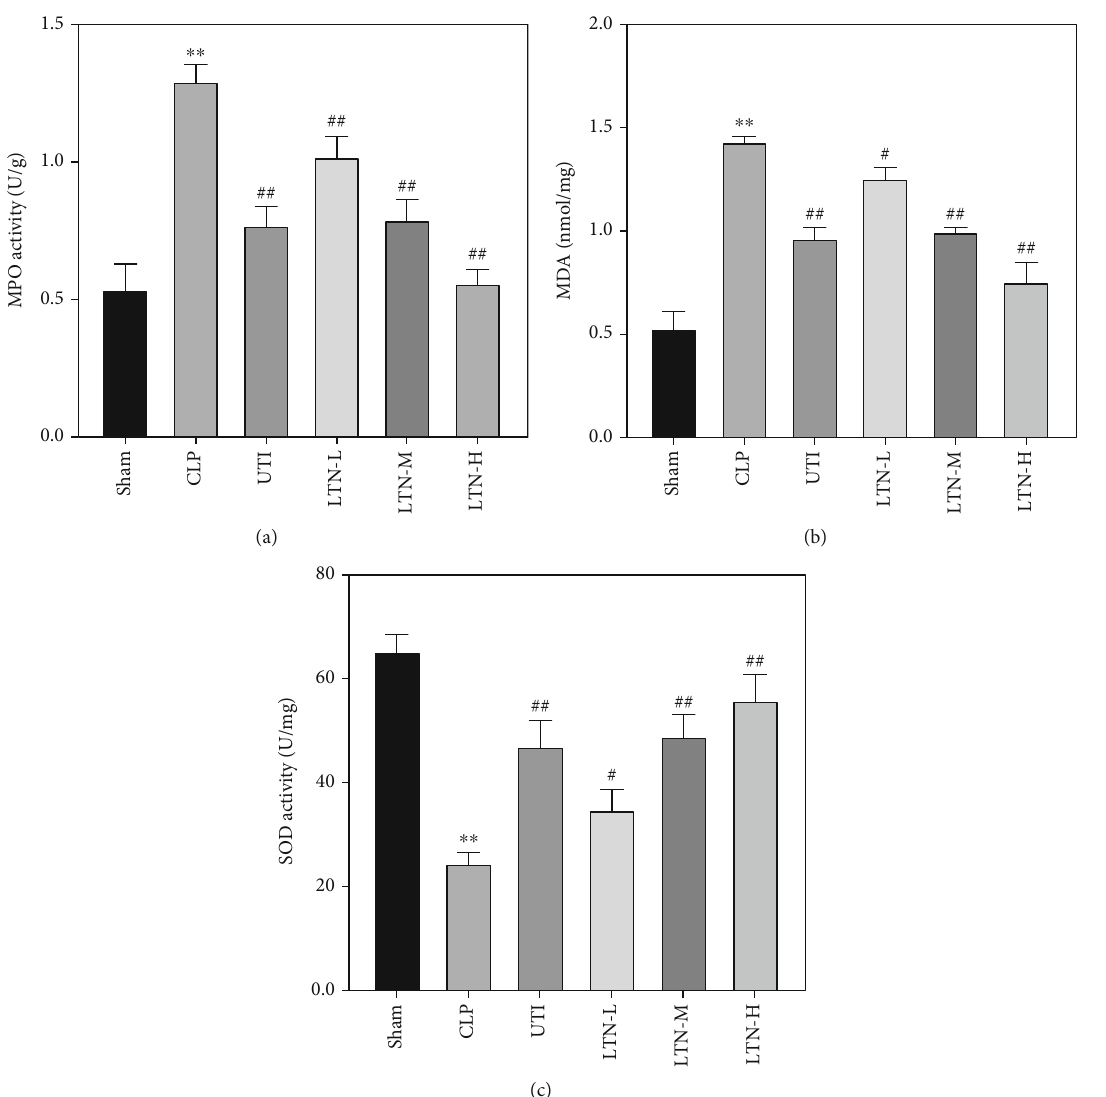
Figure 4: E ff ect of lentinan on peroxidase activity in the liver of mice with gut-origin sepsis. Detection of the contents of MPO (a), MDA (b), and SOD (c) in liver tissues of mice. The experimental results were expressed in the form of the mean ± standard deviation (SD). ∗∗ p < 0 : 01 vs. sham group. # p < 0 : 05 and ## p < 0 : 01 vs. CLP